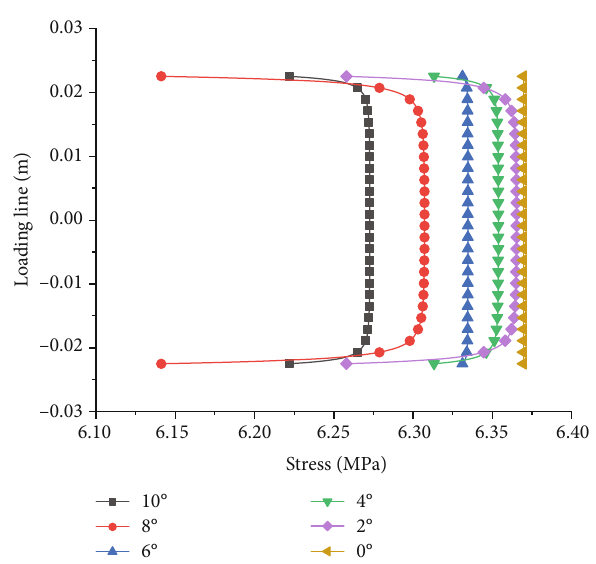
Figure 6: Distribution of tensile stress along the loading line at di ff erent deviation